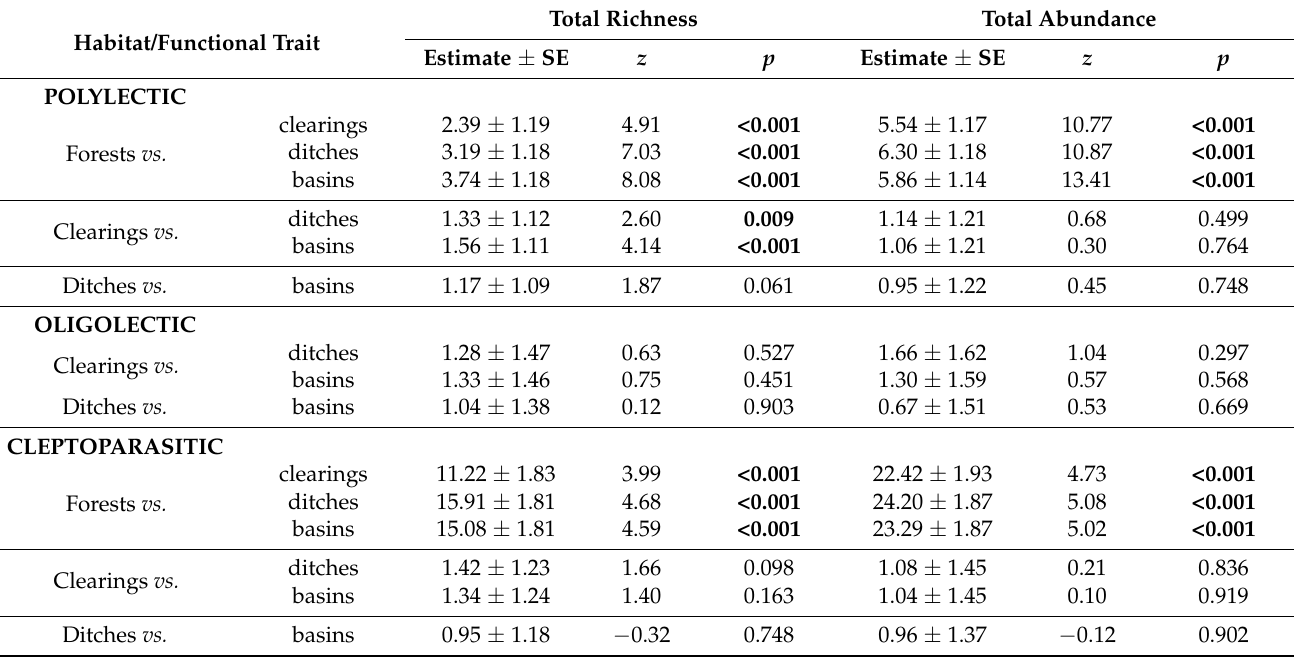
Table 4. Associations between habitat types (forests, clearings, infiltration ditches, infiltration basins) and species richness and abundance of bees differing in food preferences (polylectic, oligolectic, cleptoparasitic), based on generalized linear mixed models (GLMMs).